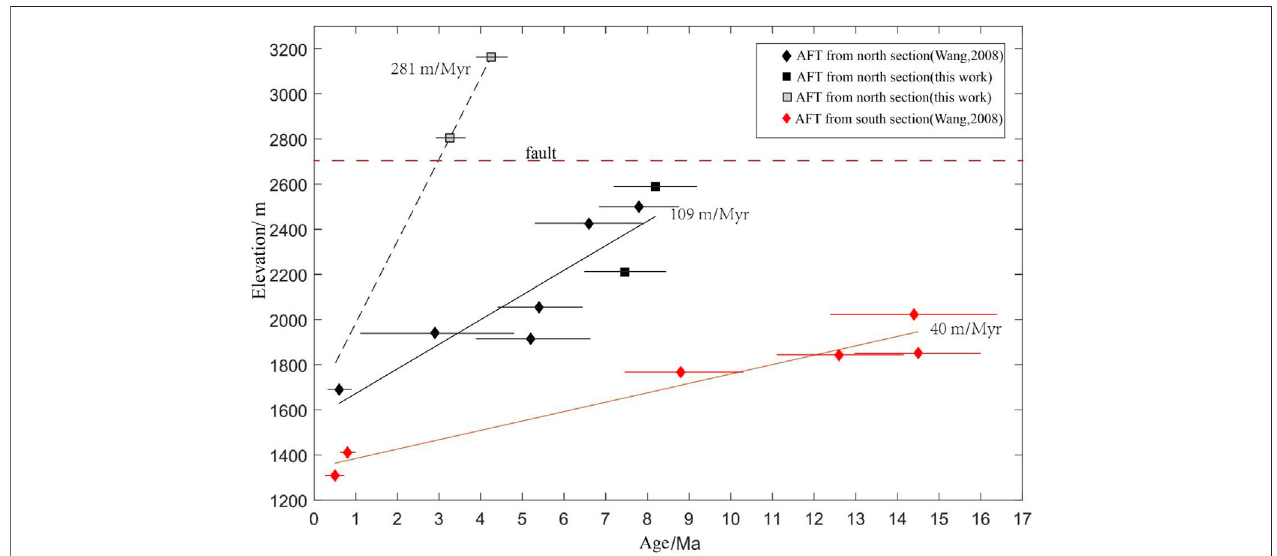
FIGURE 6 | Age – elevation relationship diagram of AFT data in different transects of the Gaoligong shear zone.